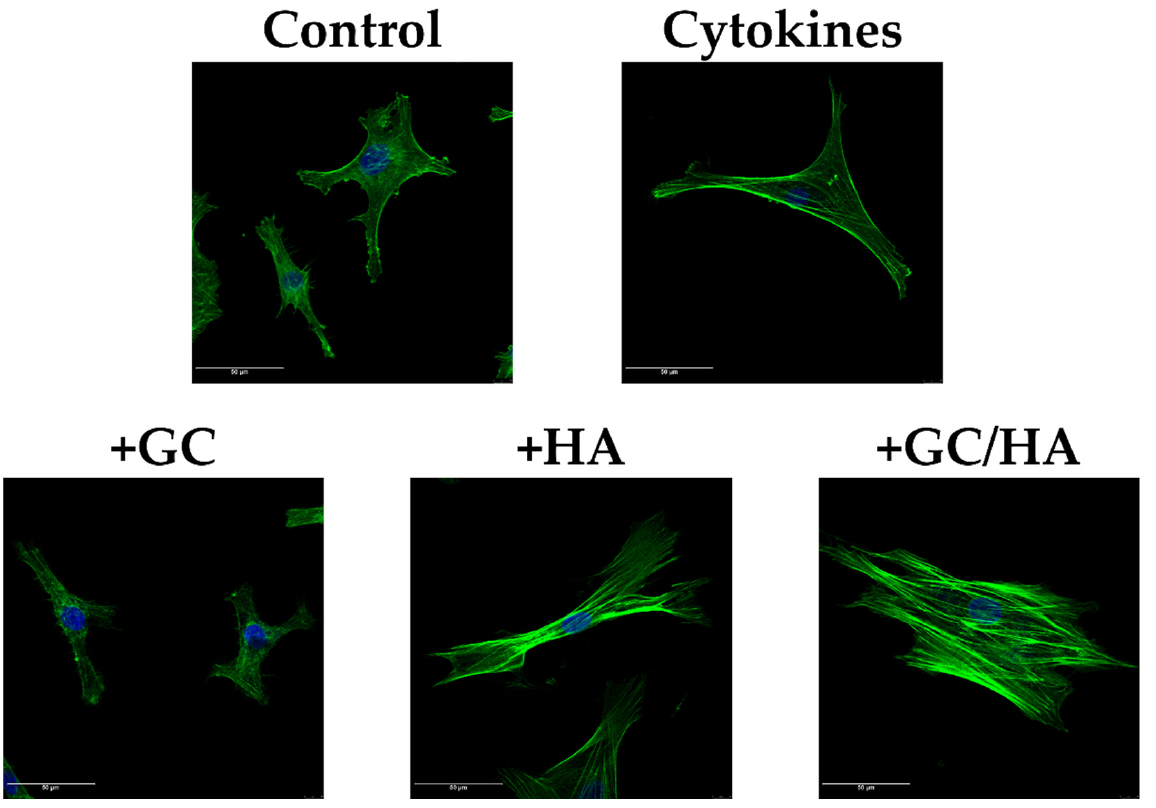
Figure 9. Confocal microscope images showing F-actin staining (green, phalloidin) and the nucleus (blue, DAPI). Scale bar 50 μ m.